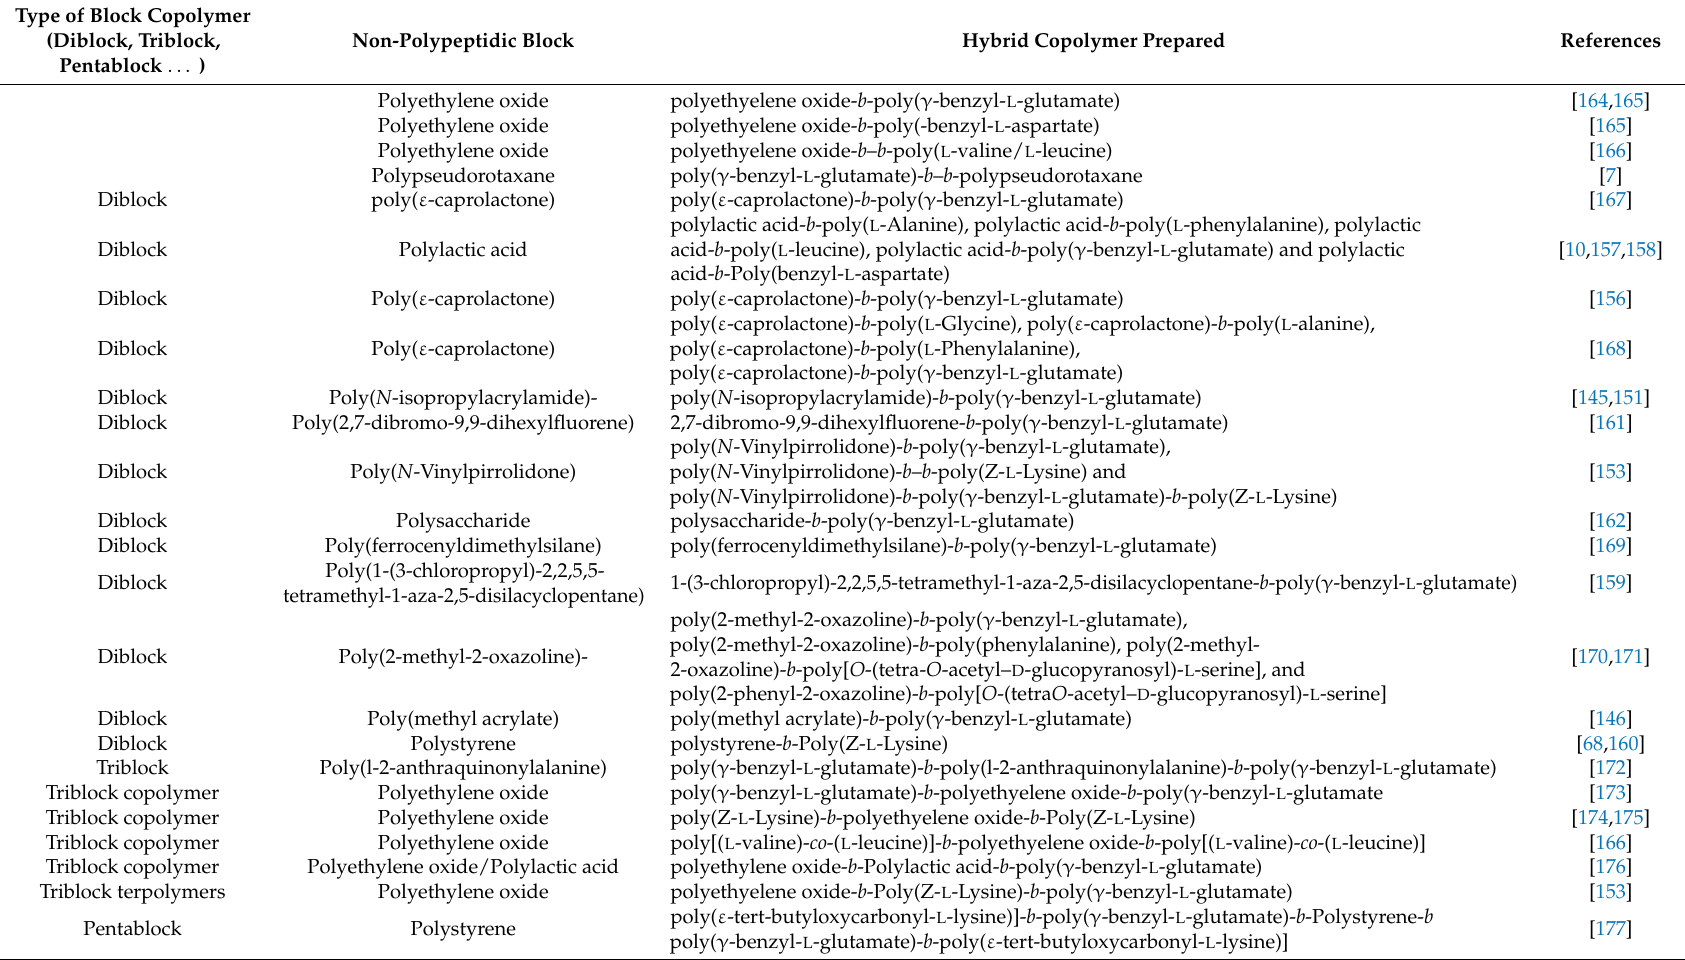
Table 4. Illustrative list of examples of hybrid block copolypeptides reported in the literature. Type of Block Copolymer (Diblock, Triblock, Pentablock . . .